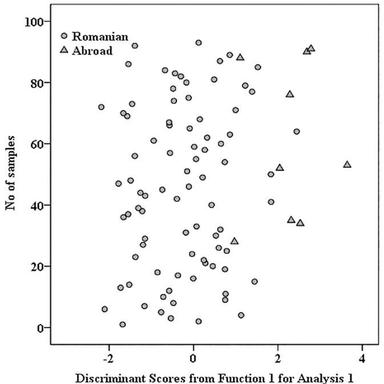
Meat samples distribution based on δ18O, Tb and Sn variables, according to origin, after applying LDA.